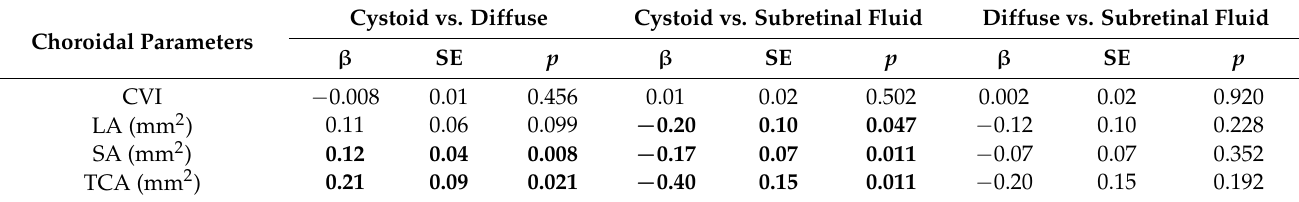
β —coefficient from the regression model, SE—standard error, p < 0.05 highlighted with bold. n = 140 eyes (13 eyes with subretinal fluid, 89 eyes with cystoid macular oedema, and 38 eyes with diffuse macular oedema). Covariates included in each model: age in years, sex (male/female), DR (NPDR/PDR), PRP (no/yes). CVI = choroidal vascularity index; LA = luminal area; SA = stromal area; TCA = total choroidal area.